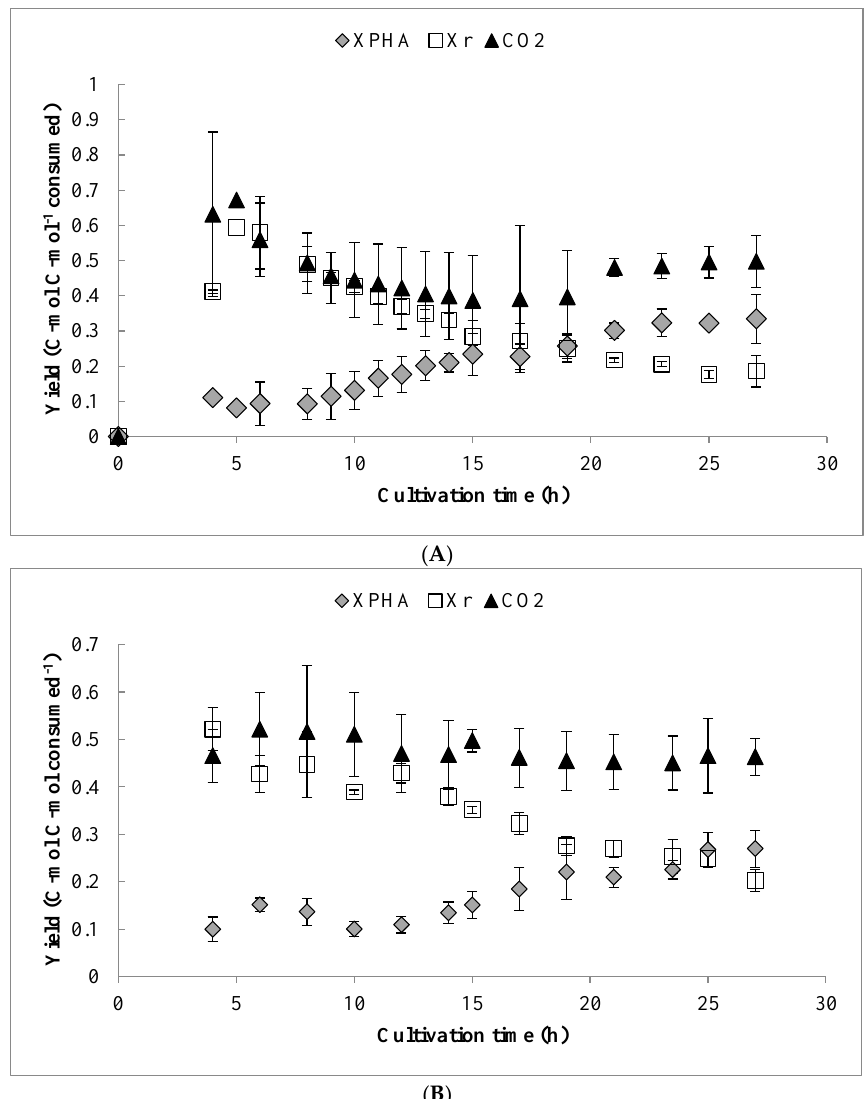
Figure 5. Overall (cumulative) yield analysis for X PHA , X r , and CO 2 over the duration of: ( A ) the pulse fed-batch cultivations and ( B ) the continuous drip feed experiments. Values expressed on a C-mol basis. Error bars represent standard deviations between three biological replicates.